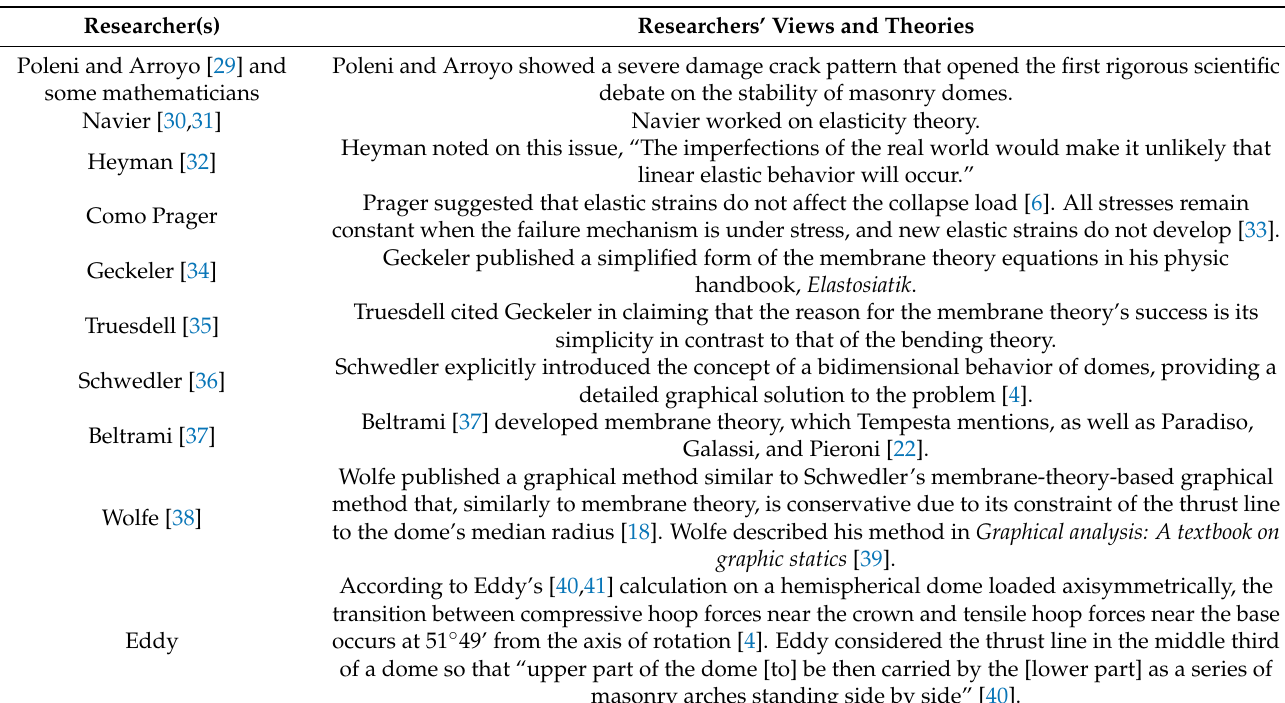
Table 2. Research on the single neutral hoop role in masonry dome